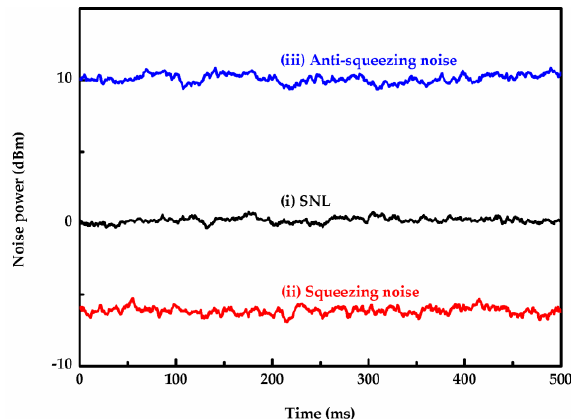
Figure 8. Measured noise power of the generated phase squeeze vacuum state at the audio frequency of 5 kHz: Curves (i)–(iii), the SNL, the squeezing noise and the anti-squeezing noise, respectively. The parameters of SA: RBW of 1 kHz, VBW of 30 Hz, and sweep time of 500 ms. All noise power traces were averaged 50 times.